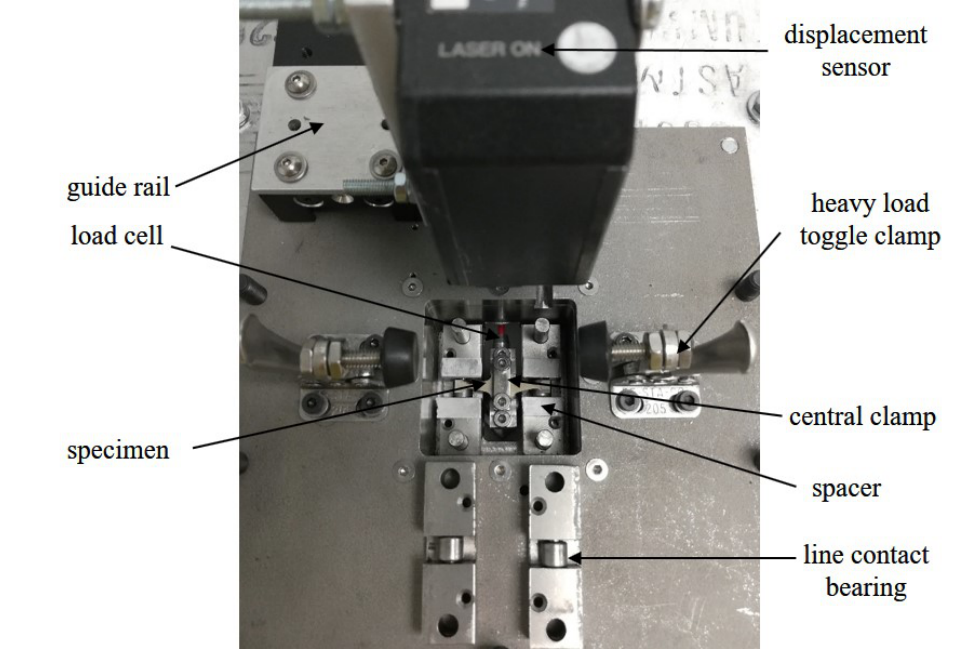
Figure 5. Fatigue test bench with a specimen